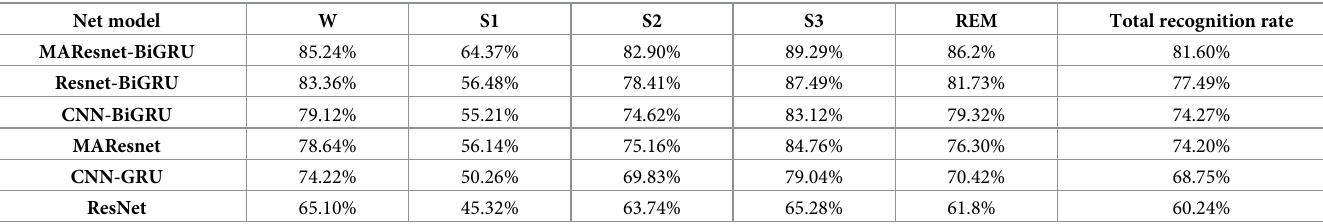
Table 5. Recall rate of each sleep stage classification under different algorithms under label smoothing on SHHS